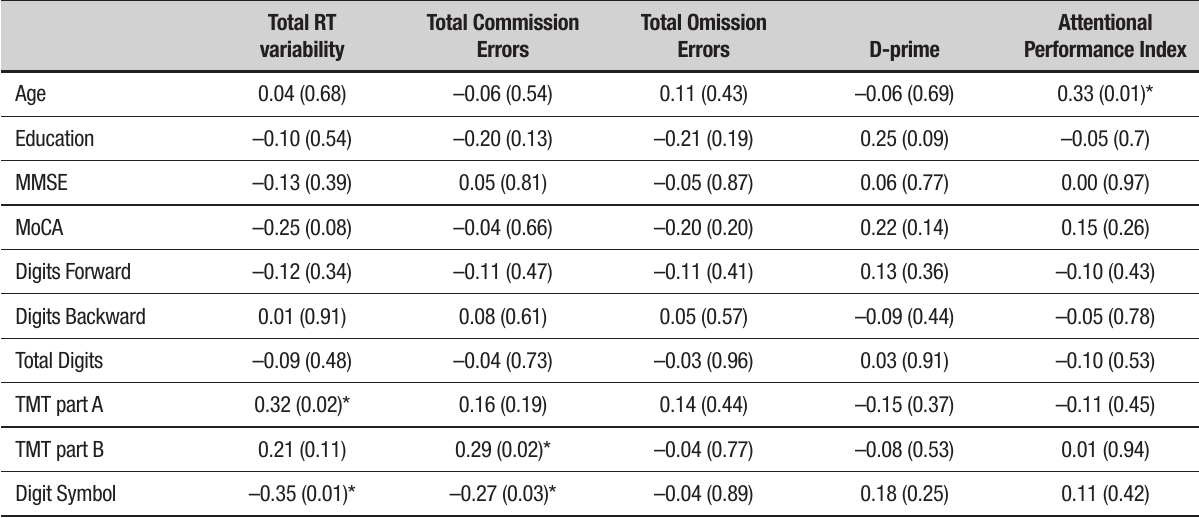
Table 5. Spearman correlation (p-value) between T.O.V.A variables and age, education, cognitive traits and attention